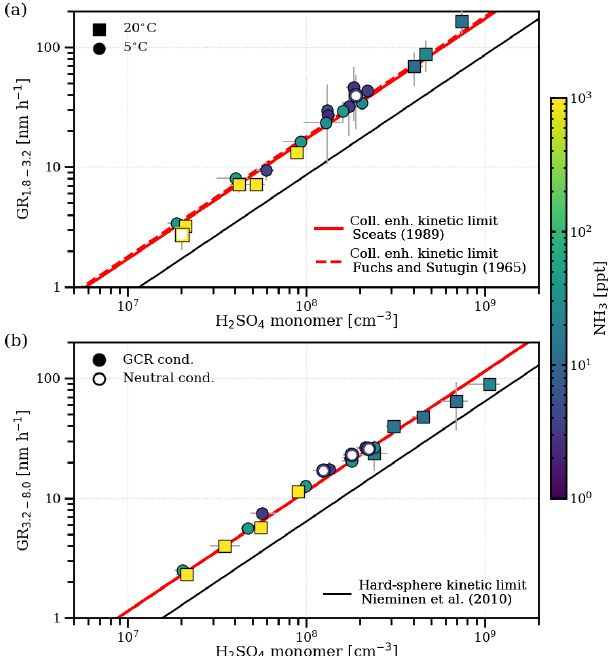
Figure 1. Growth rates of nanoparticles in two size intervals ver- sus the measured gas-phase sulfuric acid monomer concentration. Panel (a) shows growth rates for the size interval between 1.8 and 3.2nm (mobility diameter; 1.5–2.9nm in mass diameter), and panel (b) shows growth rates for the size interval between 3.2 and 8.0nm (mobility diameter; 2.9–7.7nm in mass diameter). The colour code represents the measured NH 3 concentration during the growth period. Squares are measurements at 20 ◦ C, and circles are measurements at 5 ◦ C. Filled symbols represent runs under ambient galactic cosmic ray ionization levels, and open symbols represent runs under neutral conditions. Error bars for the data points repre- sent the statistical uncertainty in the appearance time growth rate measurements and the maximum variation of the sulfuric acid con- centration during the growth period, also explaining the slight de- viations from linearity at high sulfuric acid concentrations, where stable conditions are not fully reached. The black line shows the ge- ometric limit of kinetic condensation assuming the same hydration for the condensing cluster and the measured particles (Nieminen et al., 2010). The red solid line shows the fit of Eq. (12) to the data with the Hamaker constant as the free parameter assuming a Brownian coagulation model for the enhanced collision kernel (Sceats, 1989), whereas the red dashed line uses a ballistics approach (Fuchs and Sutugin, 1965).